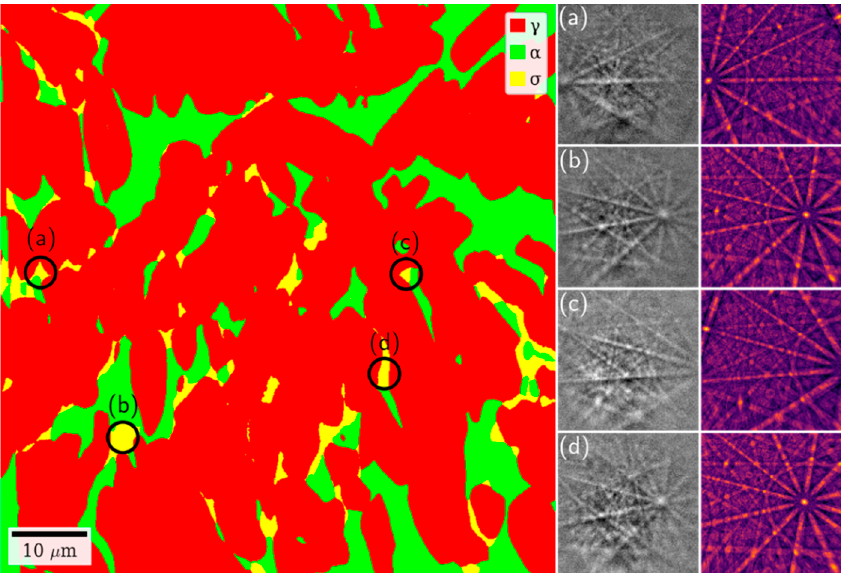
Figure 15. EBSD phase map showing an area from Wall 3 with significant amounts of sigma phase.